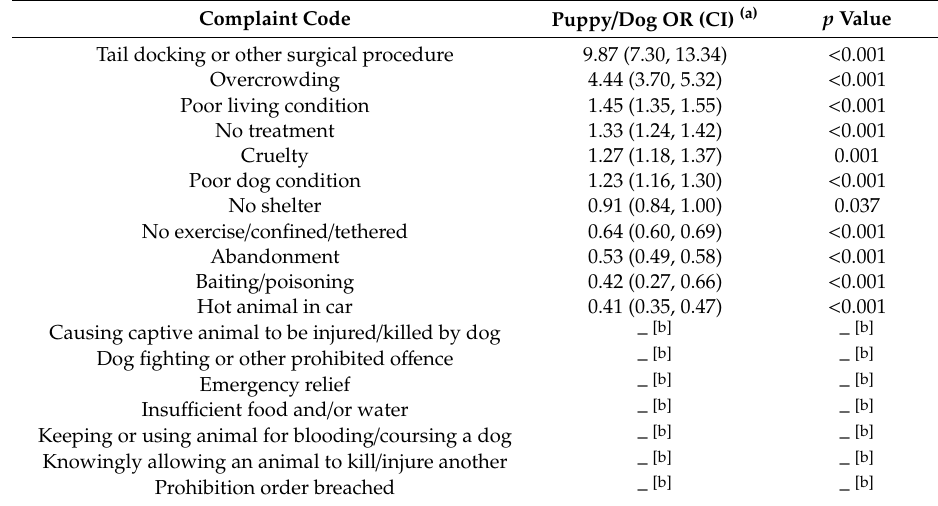
Table 1. Odds ratio of each variable in the logistic regression model of complaint codes. The outputs of these models were di ff erent complaint codes. The input variable was dog age (puppy or